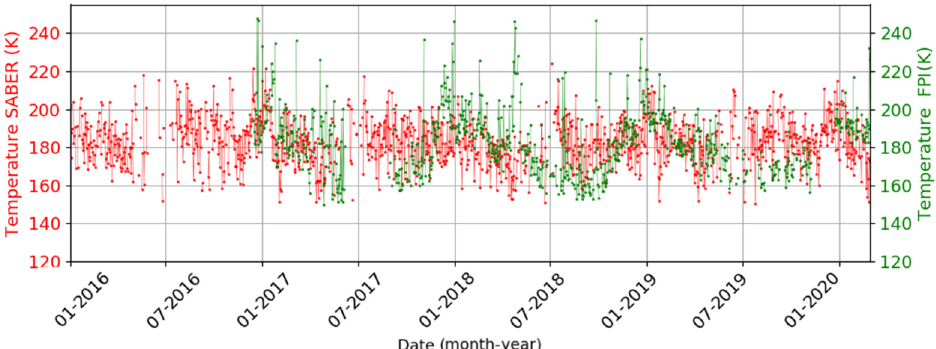
Figure 2. Red points—temperature averaged over the 95–97 km heights according to SABER data and above GPO in Tory. Green points—temperature obtained with Fabry–Pérot interferometer in GPO, Tory.